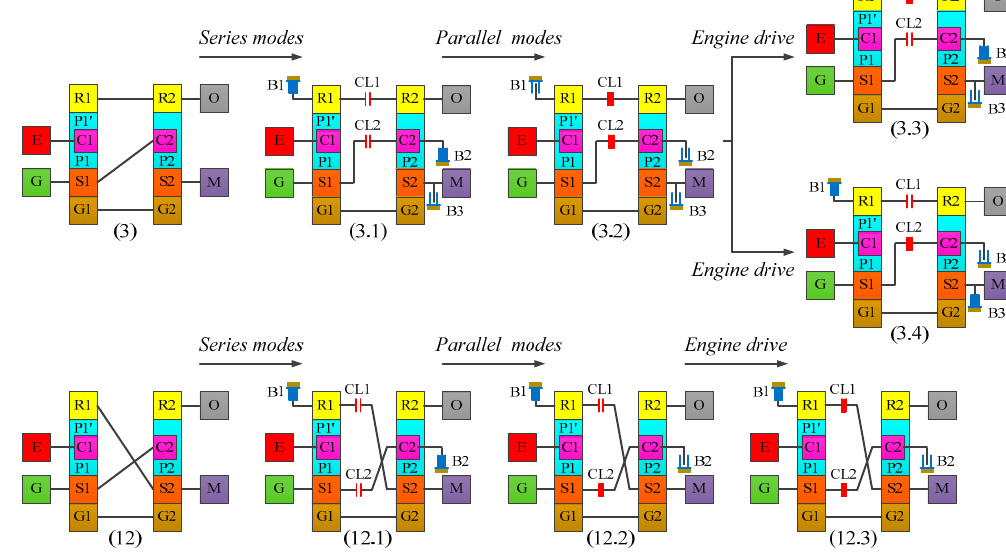
Figure 8. Process of clutch arrangement. E: engine; M: motor; G: generator; O: output shaft; CL: clutch; B: brake.